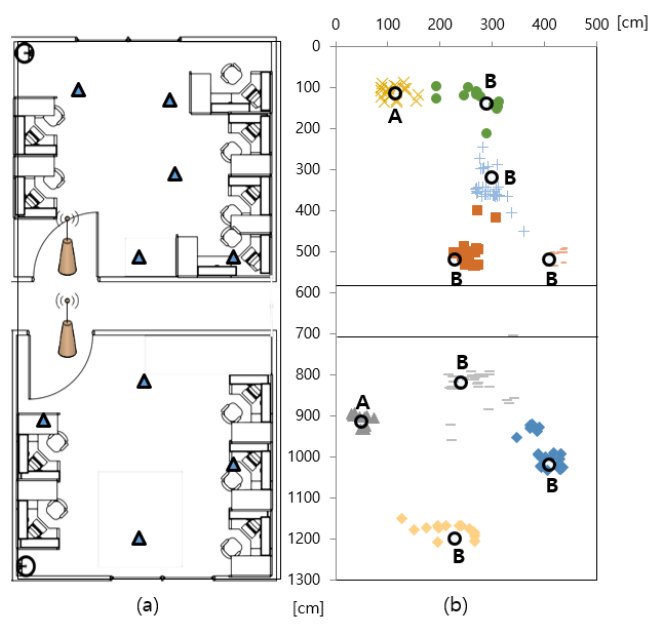
Figure 10. Comparison of measurement positions using proposed system: ( a ) test bed environments; and ( b ) localization results (Experiment